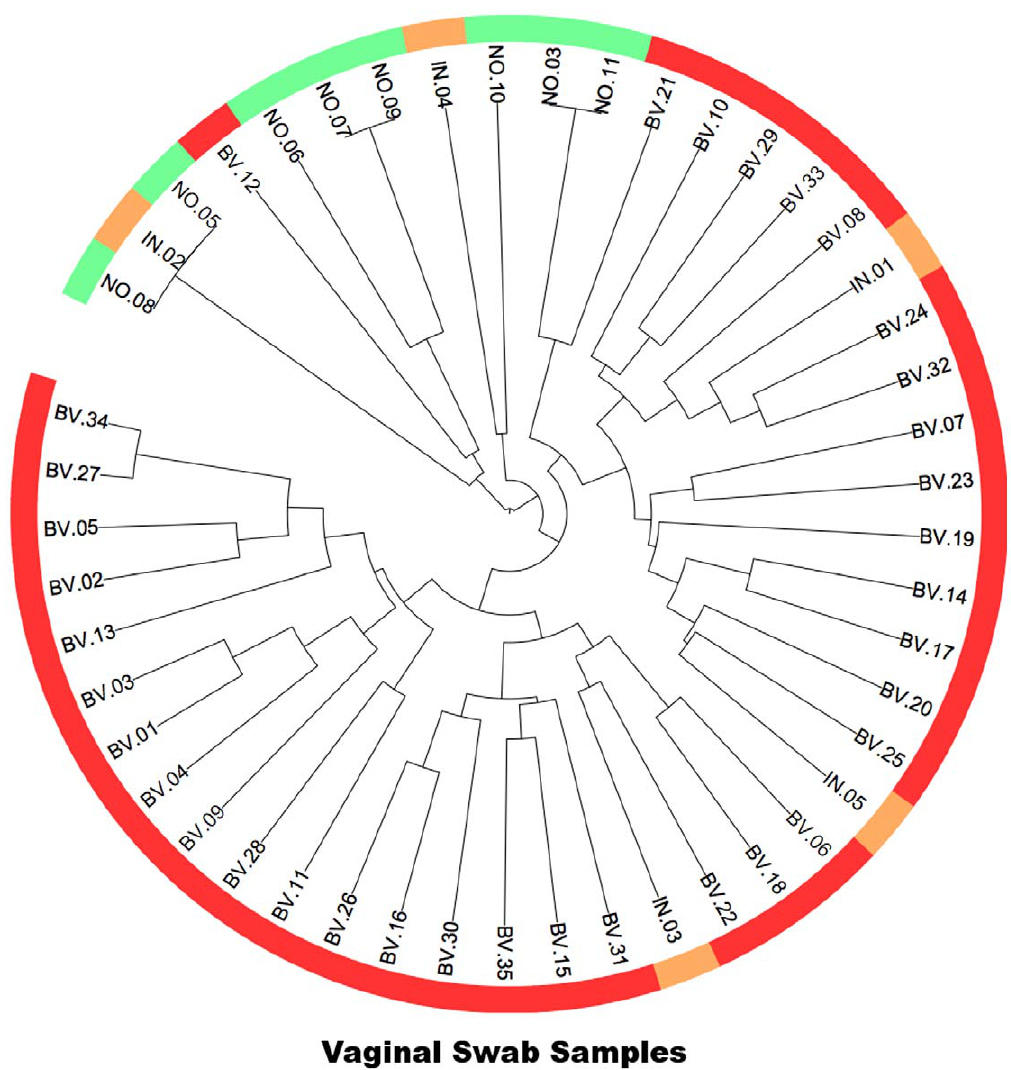
Figure 2. Hierarchical clustering results of vaginal swab samples. Samples were clustered (clustering significance: p , 0.001, UniFrac significance: p=0.016) based on the UniFrac distance metric. Red, orange and green colors indicate samples from BV, intermediate and normal Nugent categories, respectively.